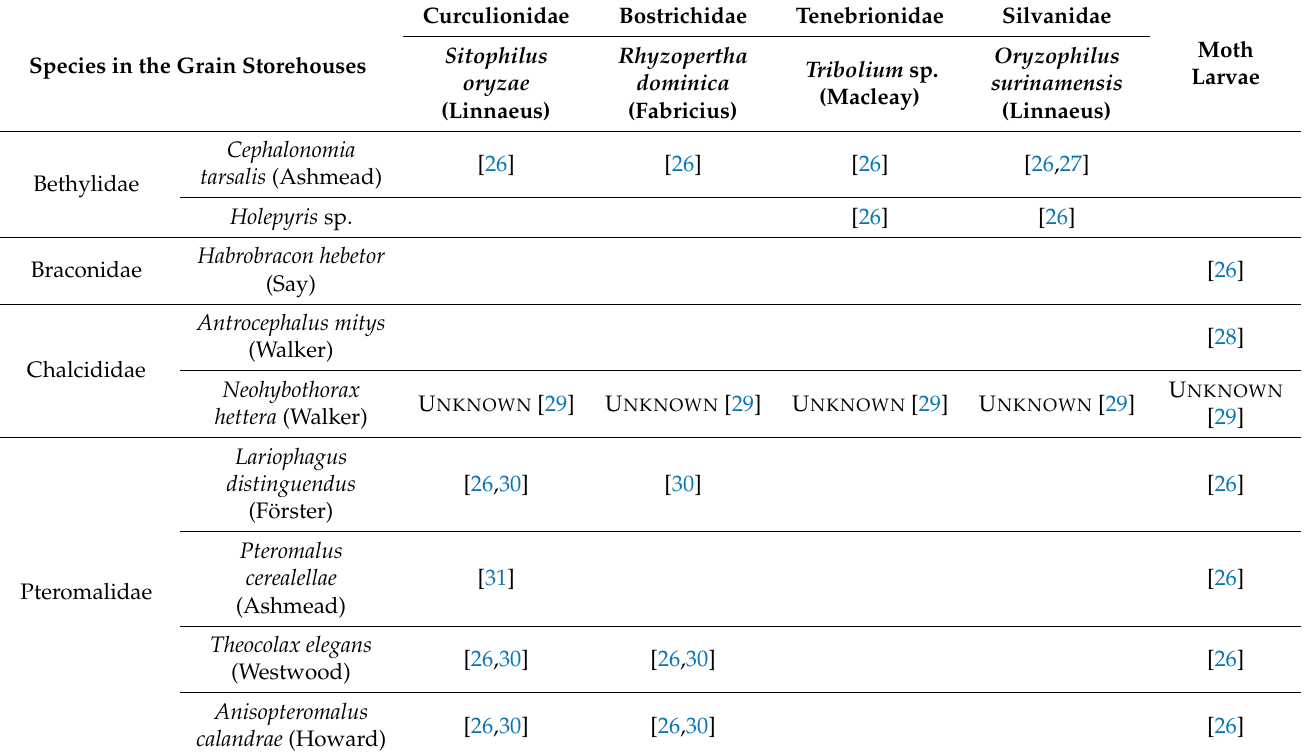
Table 1. List of main insect pests in the stored grain and their associated parasitoids.